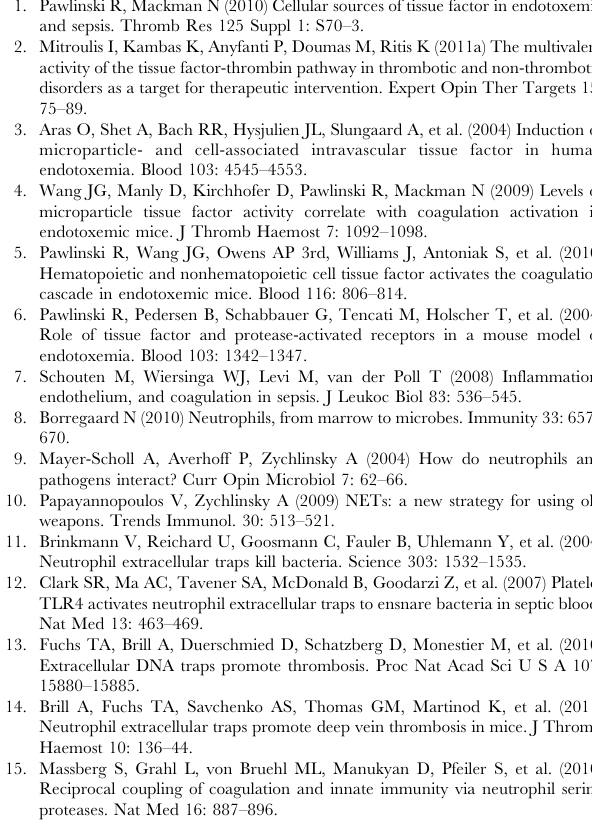
Figure S4 Localization of HMGB1 or MPO in late autophagosomes in control neutrophils treated septic serum. Control neutrophils were treated at different time points with septic serum and the colocalization of HMGB1 (A) and MPO (B) with autophagolysosomes was assessed. Autophagolysosomes were visualized by confocal microscopy as LC3B and LysoTracker double positive structures (z stack analysis, 0.3 m m per plane). (DNA labeled with DAPI; blue, anti-LC3B mAb; white, anti-MPO or anti-HMGB1 mAB; green, LysoTracker; red) (original magnification 1000 6 ). One out of three independent experiments is shown. Scale bar represents 5 m M. (TIF) Figure S5 Comparison of z-stack with single plane analysis in colocalization studies. z-axies and Single Plane analysis of TF and LC3 in sepsis PMNs or control PMNs treated with sepsis serum. Scale bar represents 5 m M.